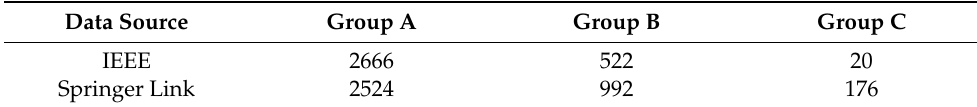
Table 2. Overview of the selected primary studies in different groups.